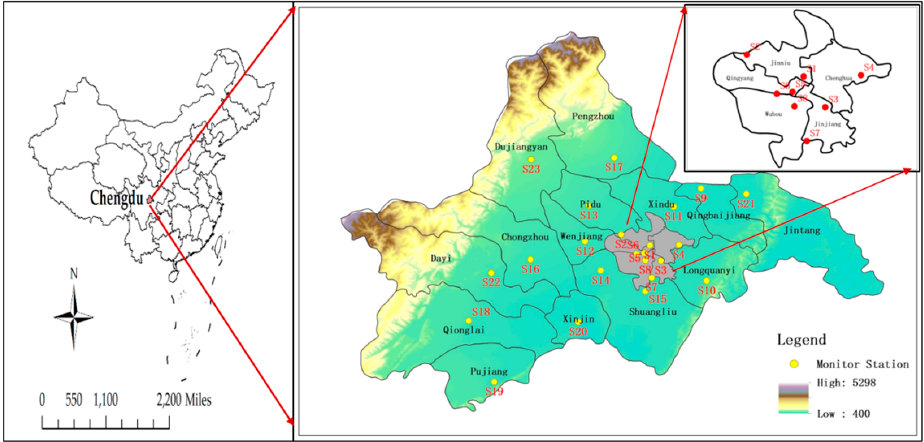
Figure 1. Terrain and locations of the 23 automatic ambient air monitoring stations in Chengdu. The upper right corner of the map shows the central city of Chengdu, and the red dots represent the position of the air monitoring stations.